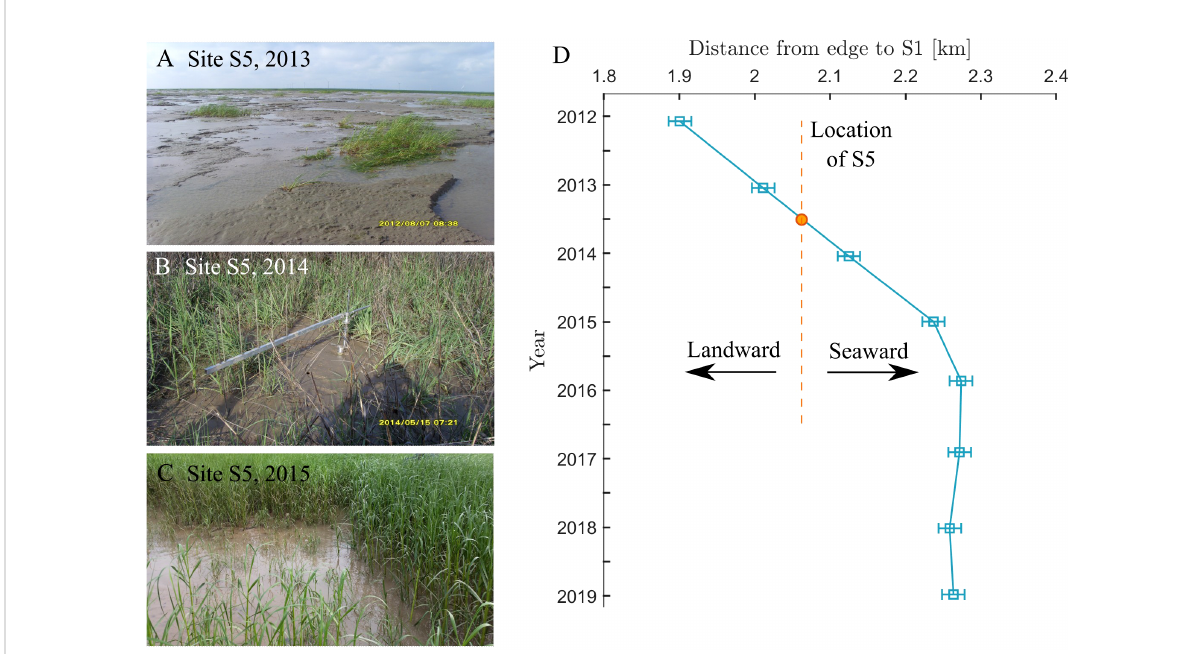
FIGURE 2 Photos taken at the observation site S5 in (A) 2013, (B) 2014, (C) 2015, and (D) the location of salt marsh edge as a function of time. The resolution of the remote sensing image (30 m) is shown by the